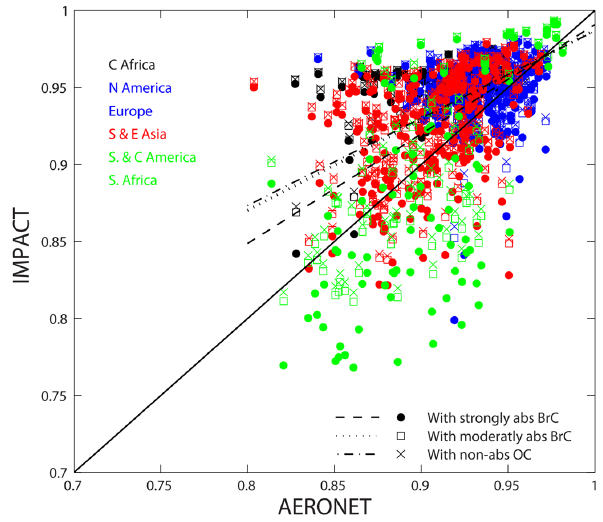
Fig. 4. Comparison of monthly mean SSA at 550nm from AERONET (1992–2011) and three model simulations (NON, MOD, and STR). The solid line indicates the 1 : 1 ratio. Data points in central Africa (C. Africa), Europe and North America, South Asia and East Asia (S & E Asia) and regions dominated by biomass burning (South and Central America (S & C America) and south- ern Africa (S. Africa)) are colored in black, blue, red, and green, respectively. The linear fitting functions are y = 0 . 71 x + 0 . 3 for the STR BrC (dashed line; solid circles), y = 0 . 58 x + 0 . 4 for the MOD BrC (dotted line; open squares), and y = 0 . 57 x + 0 . 42 for the non- absorbing OC (dash-dotted line; cross